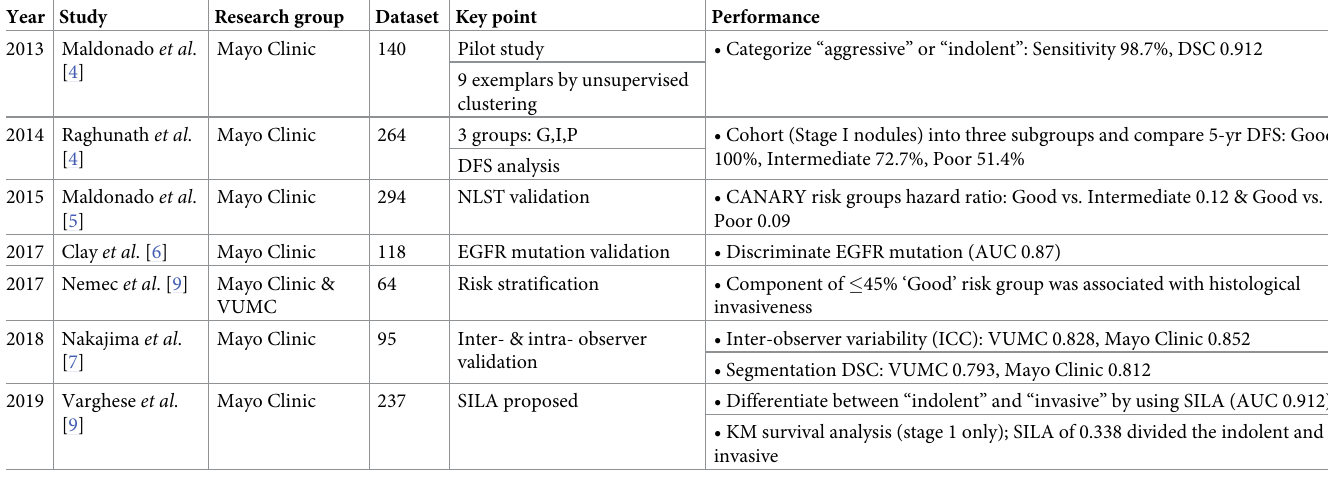
Table 4. Previous studies related to CANARY development and